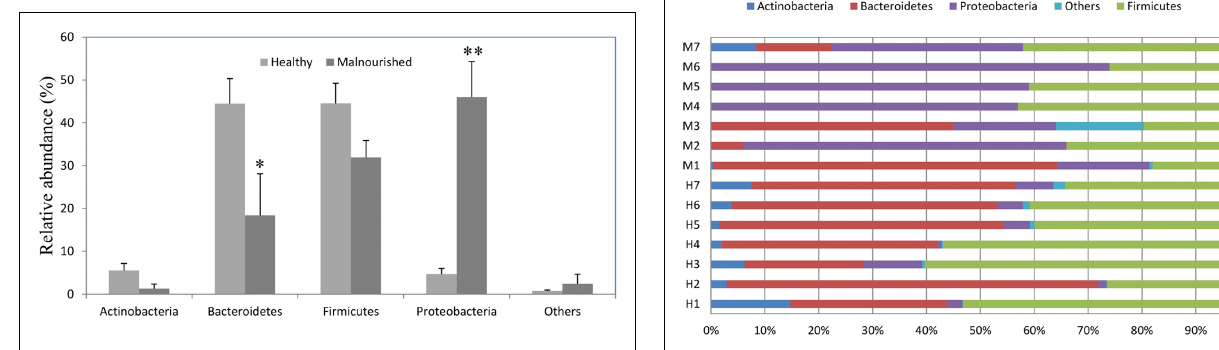
FIGURE 2 | Relative abundance (percentage of sequences) of the dominant bacterial phyla in the gut of healthy and malnourished children. Values are expressed as mean ± SE. ∗ Indicates significant difference ( p < 0.05) and ∗∗ ( p < 0.001) between two groups of children. Light gray, healthy; dark gray, malnourished children.